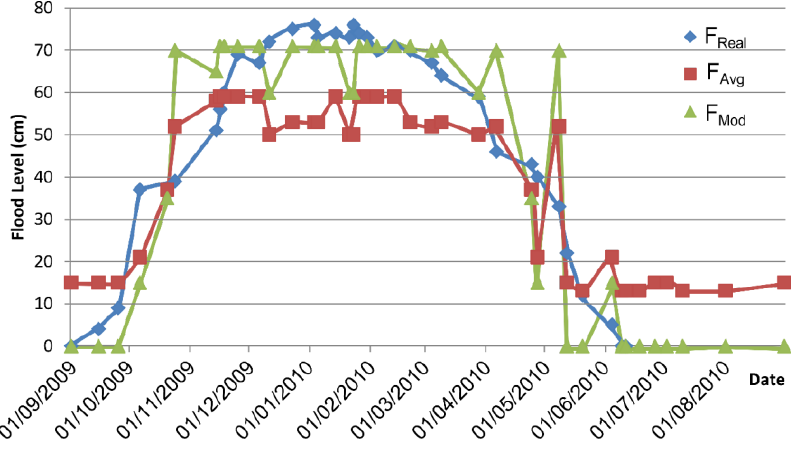
Figure 8. Flood level estimation of the ICARO